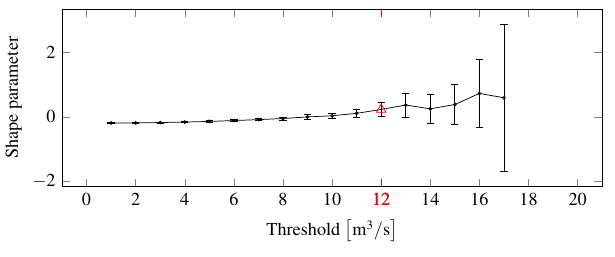
Figure 5. Modified scale parameter versus threshold, with the cho- sen threshold shown in red.